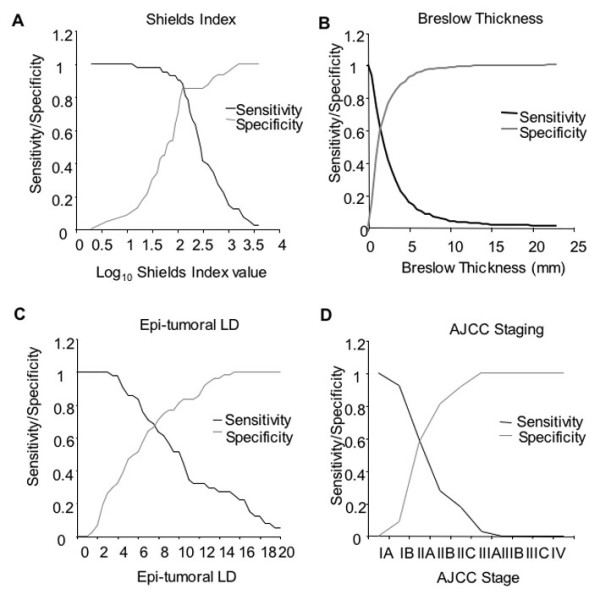
Sensitivity and specificity curves for the different prognostic factors. The sensitivity (i.e. the number of correctly predicted patients with metastatic spread) and specificity (i.e. the number of correctly predicted patients that did not develop metastases) were plotted on the same axes as a representation of the predictive value of the prognostic test. The point at which the two lines intersect represents the optimal cut-off point for determining a positive or negative test result in order to achieve the best sensitivity and specificity for the test. A) Shields Index B) Breslow thickness for the 4500 patients included in the Frenchay Hospital Melanoma Registry C) Epi-tumoural LD D) AJCC stage.